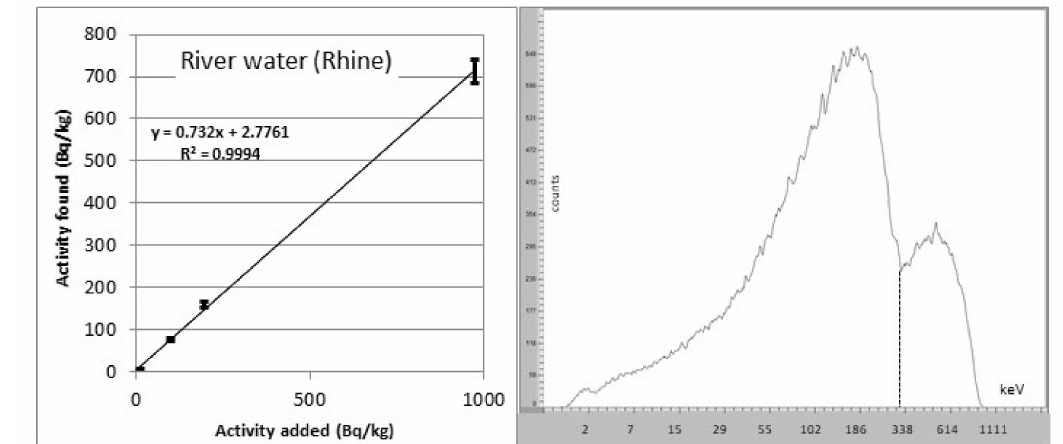
Figure 7. Left: linearity function of 90 Sr LSC measurements in river water (source: [20]). Right: 90 Sr spectrum counted on a Hidex LSC counter. The spectrum is strongly quenched.